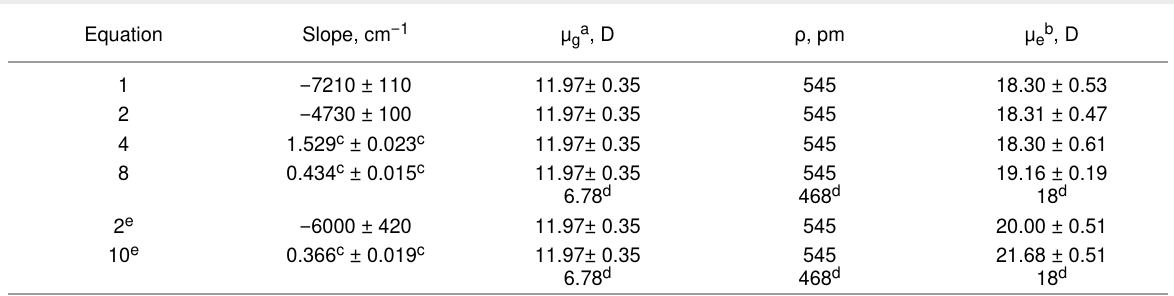
Table 2: Ground ( μ g ) and excited ( μ e ) state dipole moments of